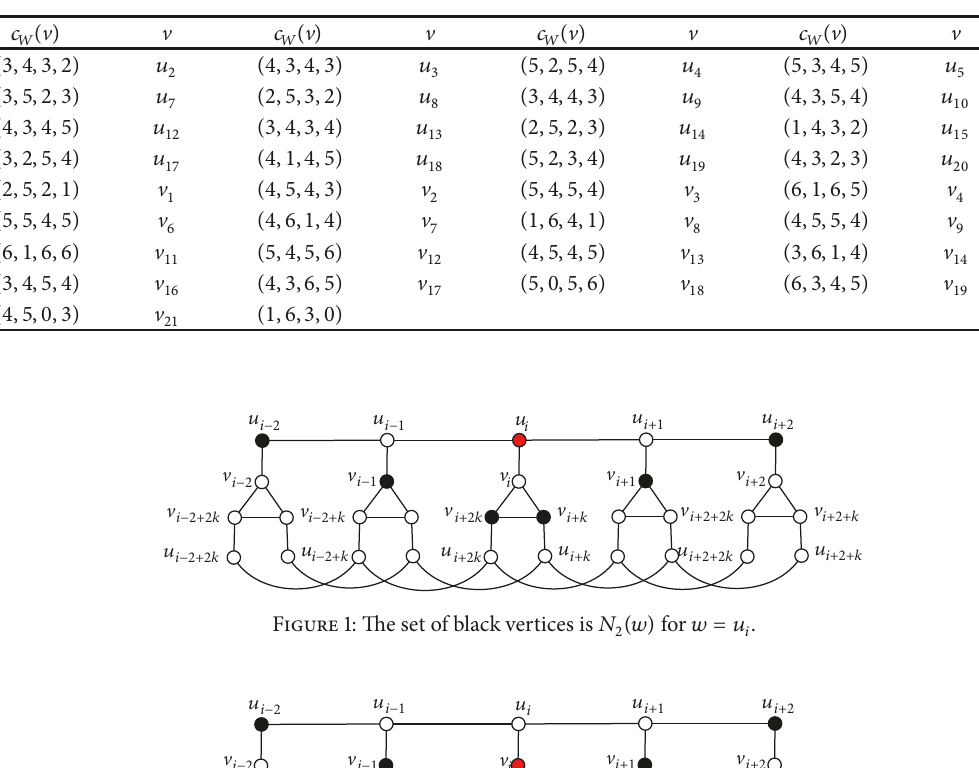
Table 15: The code 𝑐 𝑊 ( V ) of V with respect to 𝑊 = { V 14 , V 17 , V 20 , V 21 } in 𝑃(21, 7) .